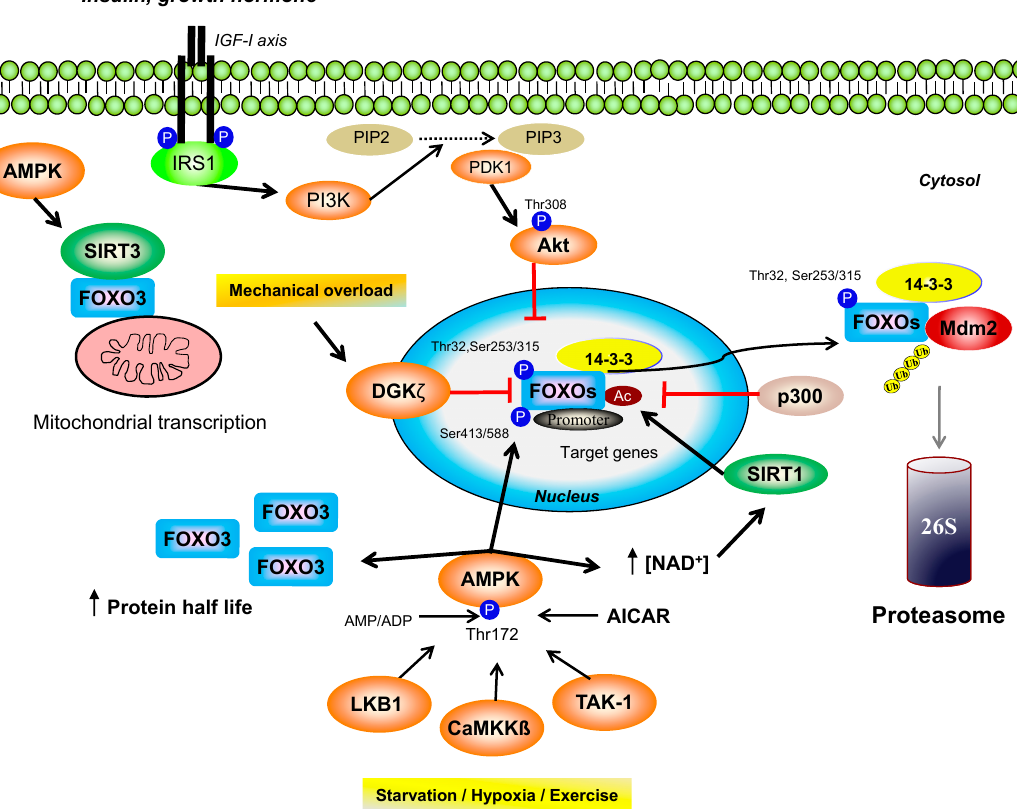
Figure 3. (AMP)-activated protein kinase AMPK and forkhead box class O subfamily protein FOXO regulation in skeletal muscle. FOXO proteins are phosphorylated and inhibited by protein kinase B (PKB or Akt) in response to insulin or growth factor. Under the condition of energy stress, AMPK, which is activated by the AMPK kinases (AMPKK) Ca 2 + / calmodulin- dependent protein kinase ß (CaMKKß), liver kinase B1 (LKB1), and transforming growth factor ß-activated kinase 1 (TAK-1), phosphorylates and increases FOXO3 activity. AMPK is also involved in FOXO deacetylation through Sirtuin 1 (SIRT1) and Sirtuin 3 (SIRT3). AMPK activation by 5-aminoimidazole-4-carboxamide-1-ß-D-ribofuranoside (AICAR) stabilizes FOXO3 by increasing its protein half-life. Moreover, AMPK favors the association between FOXO3 and mitochondrial DNA through SIRT3, mediating the transcription of mitochondrial genes. During mechanical overload, FOXO3 transcriptional activity is inhibited by diacylglycerol kinase ζ (DGK ζ ) by a mechanism independent of DGK ζ kinase activity within the nucleus. Cytosolic FOXO3 is targeted by E3 ligase murine double minute 2 (Mdm2) for degradation via the ubiquitin-proteasome system. FOXO3 and FOXO4 are acetylated by the histone acetyltransferase p300. Abbreviations undefined in the main text: IRS1, insulin receptor substrate 1; PIP2, phosphatidylinositol 4,5-bisphosphate; PIP3, phosphatidylinositol